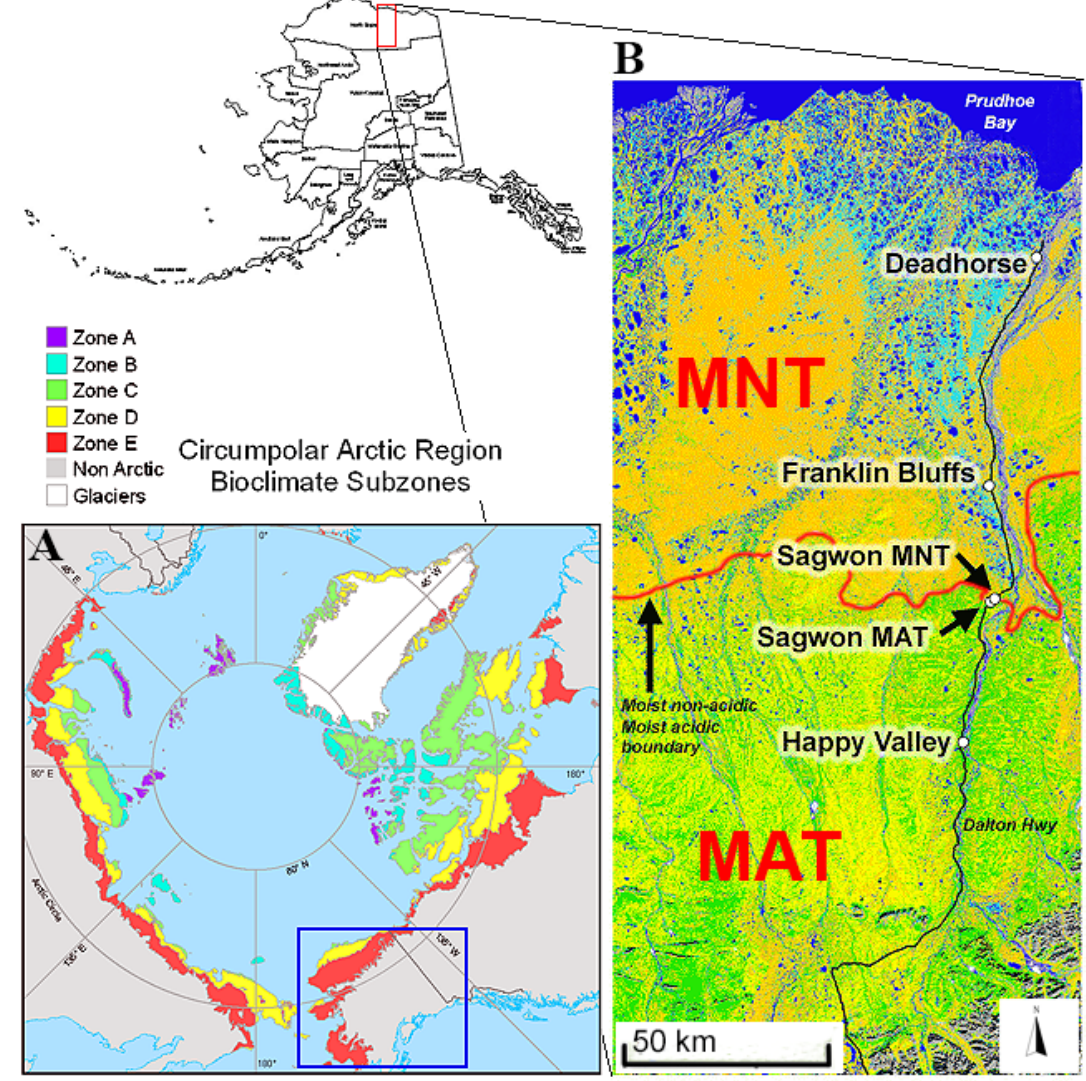
Figure 1. ( A ) The Arctic bioclimate subzones of the Circumpolar Arctic Vegetation Map [35]. (B ) Low Arctic part of the NAAT with the study locations Happy Valley, Sagwon, Franklin Bluffs, and Deadhorse. The map is based on the Kuparuk River Basin Vegetation map [36], which is derived from a Landsat